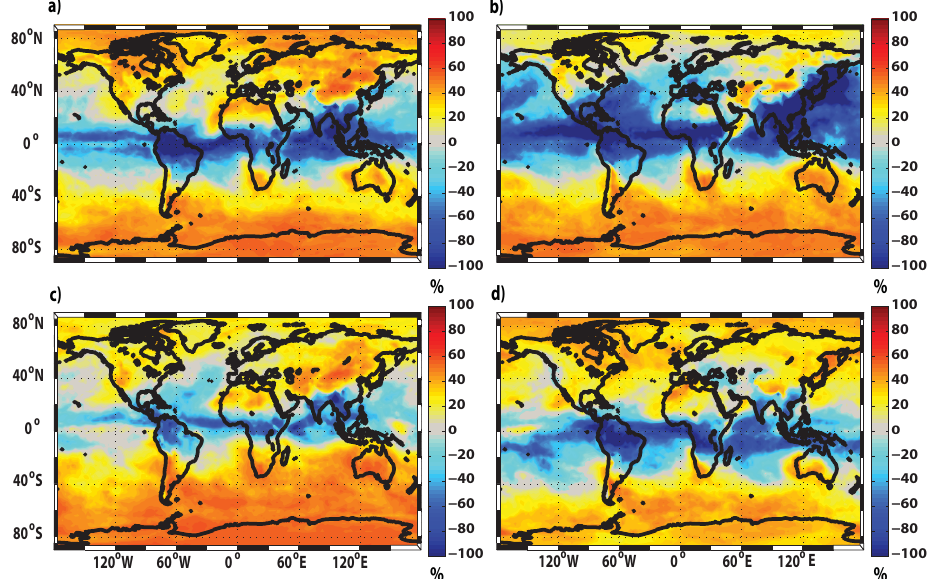
Fig. 9. Percent difference in seasonally averaged Fe d deposition rates using fixed a priori (1%) DIF values and explicit calculations for (a) March–May (MAM), (b) June–August (JJA), (c) September–November (SON), and (d) December–February (DJF). Cold colors show the areas where the model-predicted Fe d deposition rates are higher compared to a prior assumptions, warm colors indicate the opposite.